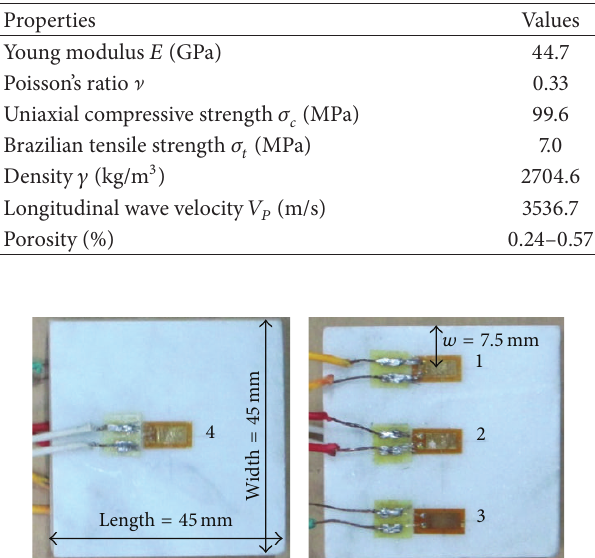
Table 1: Physical and mechanical properties of the tested marble.